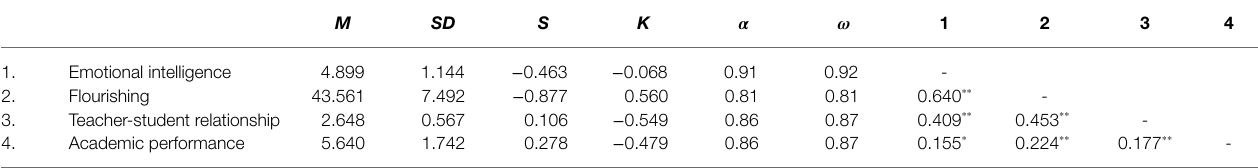
TABLE 1 | Descriptive statistics, reliability indexes, and correlations for the study variables. M SD S K α